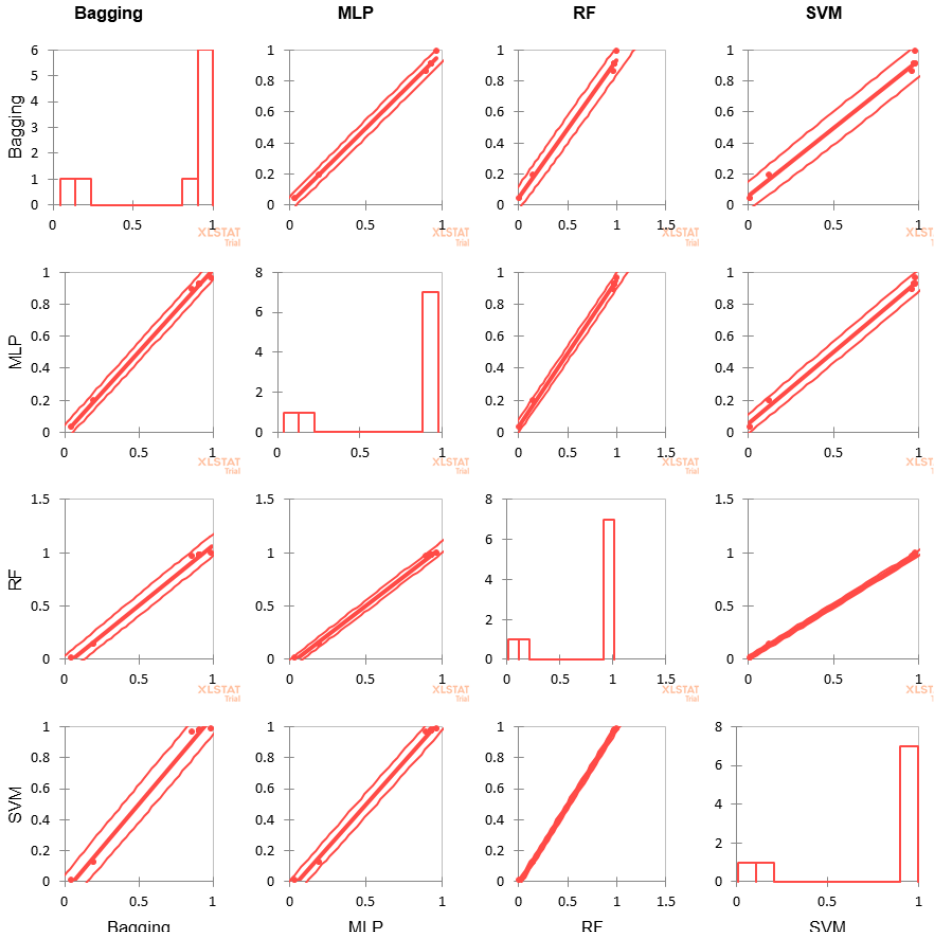
Figure 4. Scatter plot of the correlation analysis for the four classifiersestablishes how well the chosen value of k matches across the different algorithms.